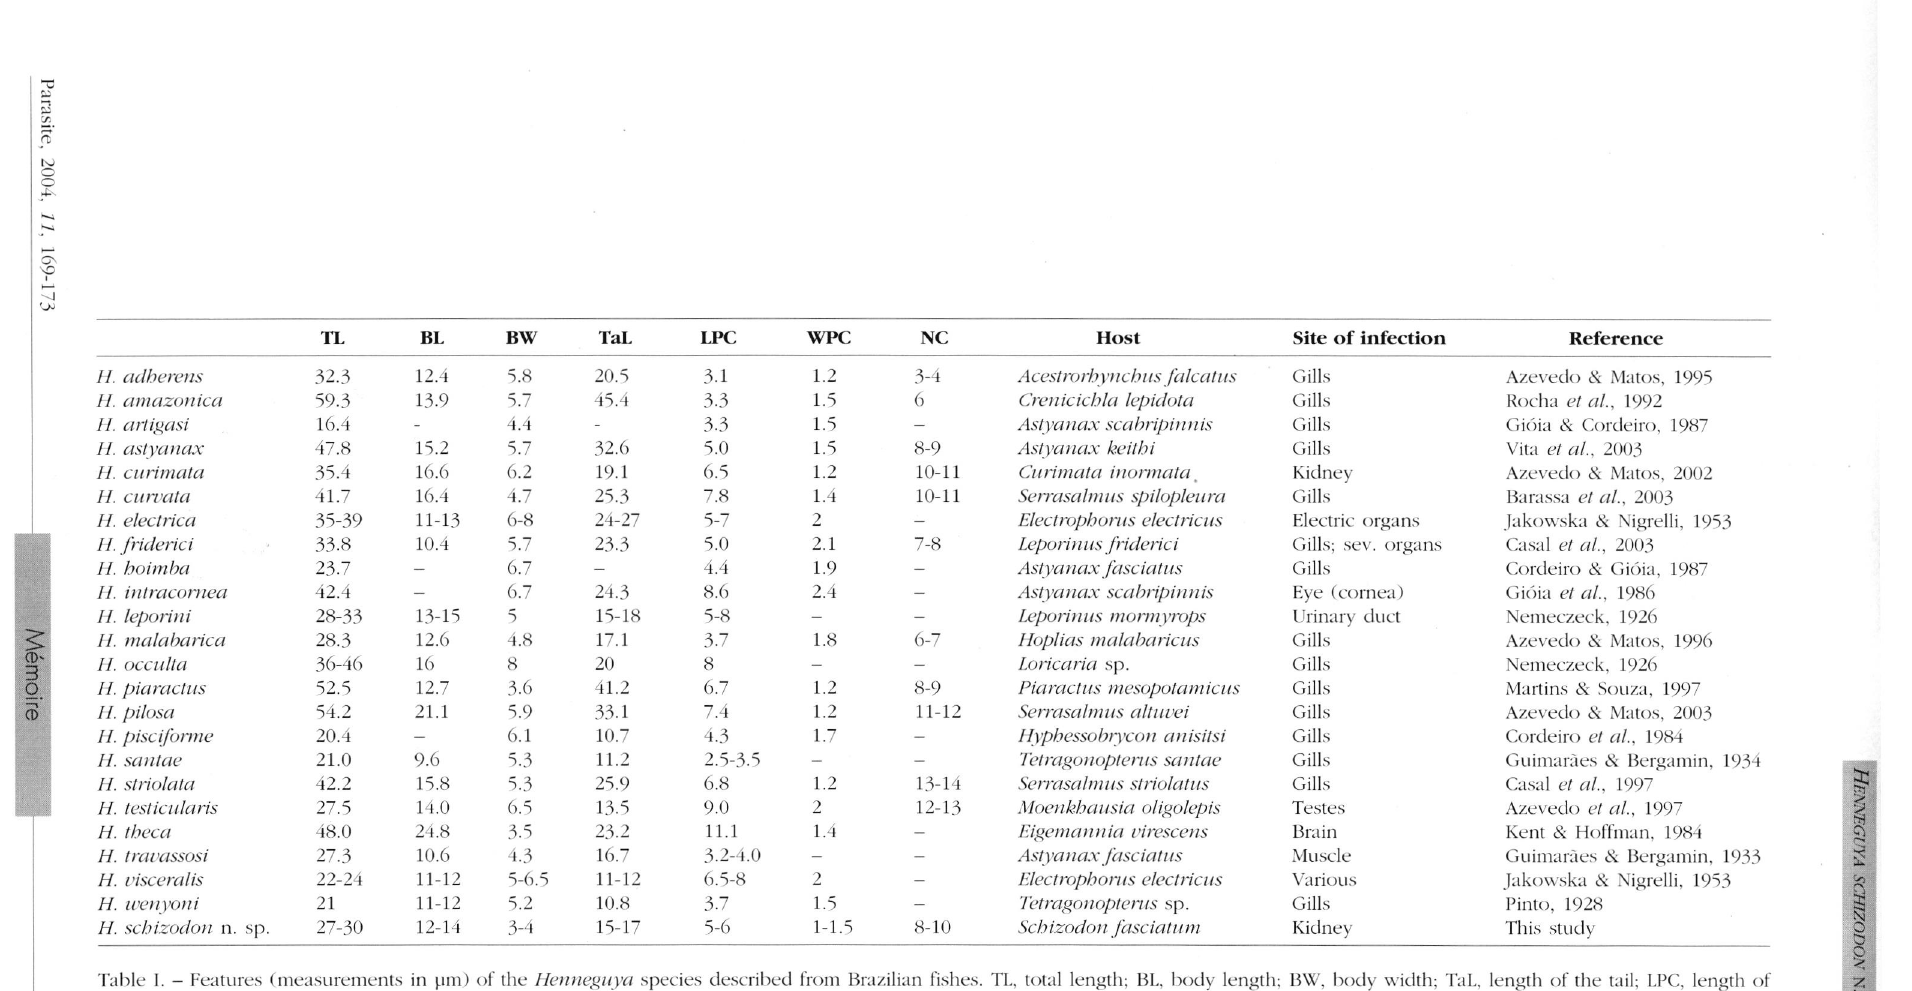
Table I. - Features (measurements in um) of the Henneguya